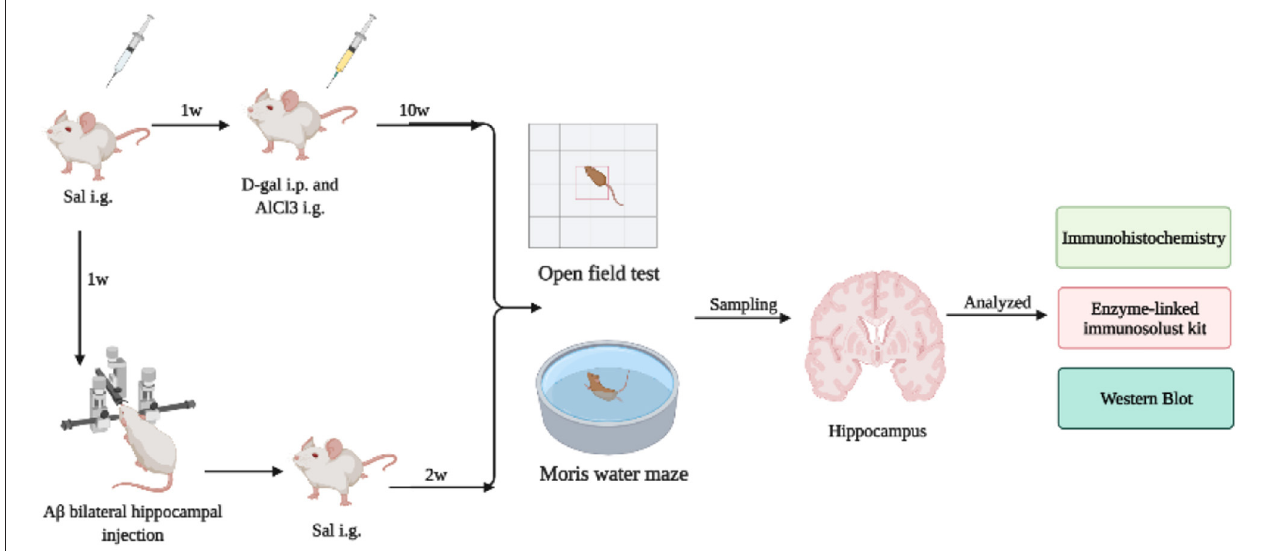
FIGURE 1 | The study flow diagram for animal experiments. The experimental animal design was mainly divided into two parts. Part I investigated the influence of Sal on the AD mice model induced by A β 1-42. Part II further explored the potential mechanism of Sal on D-gal/AlCl 3 -induced AD mice and inquired further as to how the Sal mechanism acts in pyroptosis. Firstly, an Open-field test and Morris water maze were performed to test the behavioral performance of AD mice. Then, mice were killed by cervical dislocation to collect hippocampal tissues and collected for further histologic analysis, including Immunohistochemical staining, Enzyme Immunoassay Kit, and Western blotting